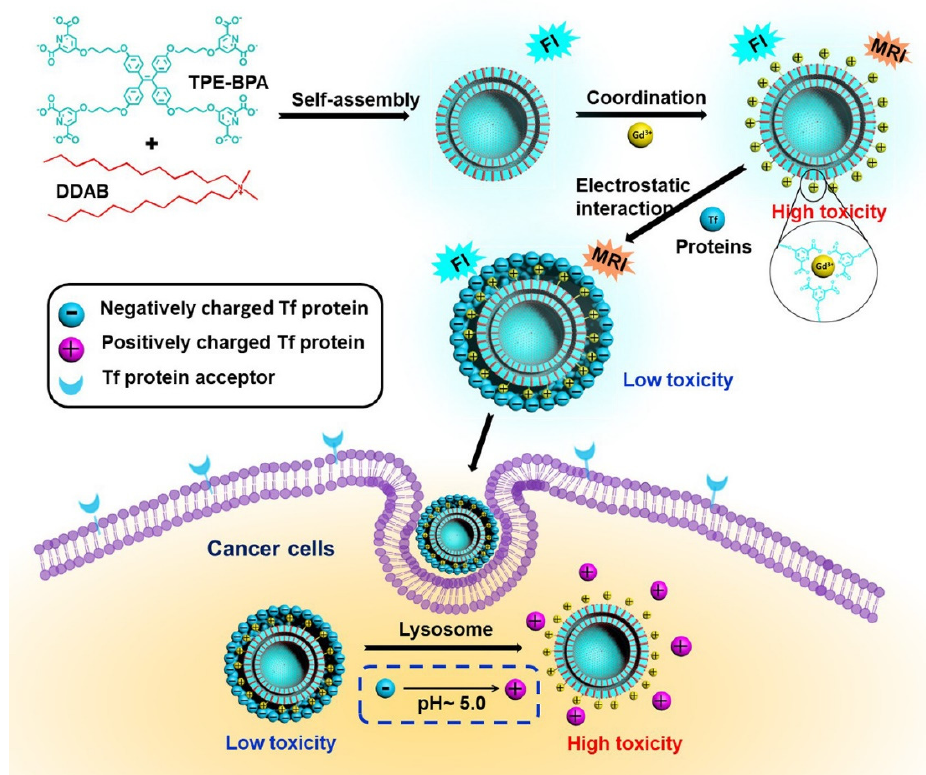
Figure 30. Systematic representation of self-assembled multifunctional AIE active Tf-coated vesicle for fluorescence imaging and targeted cancer therapy. Reprinted from reference [155] with the permission of the American Chemical Society.